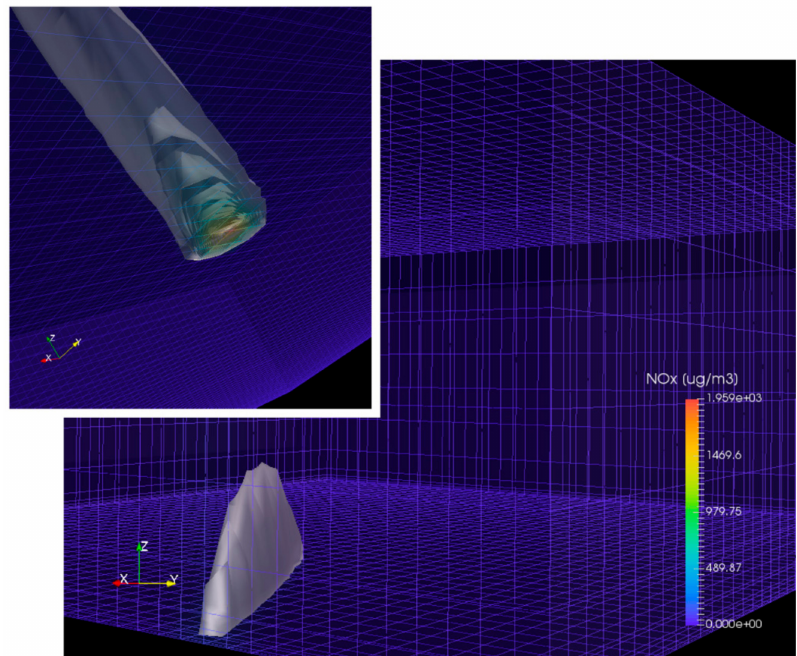
Figure 2. Example numerical results of the simulated ship plume dispersion of ship event J_20100811 using the EPISODE-CityChem model. Larger panel: the shape of the 3-D ship plume within a subset of the model grid. Inserted smaller panel in the upper-left-hand corner: the view of the same ship plume as seen upwards from below the ground surface. Colored contours at the surface indicate the modeled hourly mean concentration of NO X ( µ g · m − 3 ) in the ship plume. Blue lines illustrate the Eulerian 3-D model grid